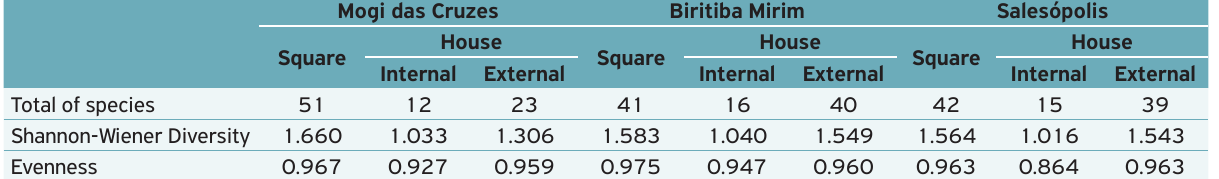
*Law nº 9.866. Table 2. Total number of ant species recorded in the urban centers of the Alto Tietê, São Paulo, Brazil, and results of Shannon- Wiener diversity and Pielou Evenness.